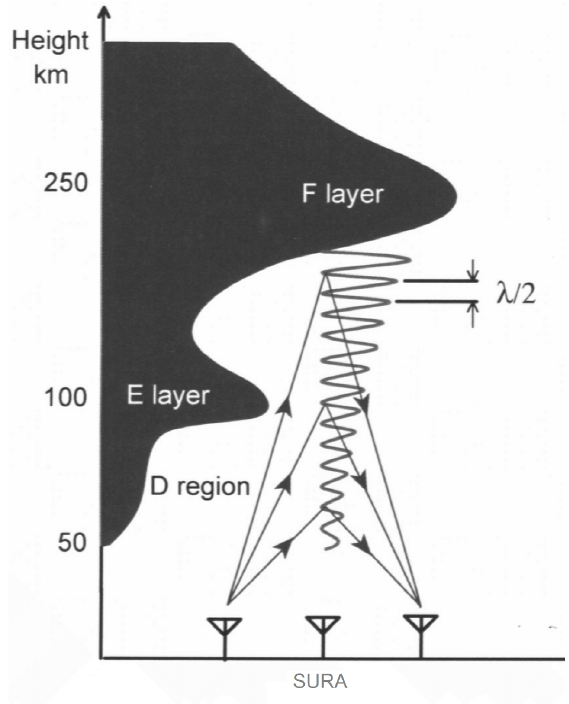
Fig. 1. A scheme for production of the arti(cid:12)cial periodic irregularities of the iono- spheric plasma and their sounding by pulsed